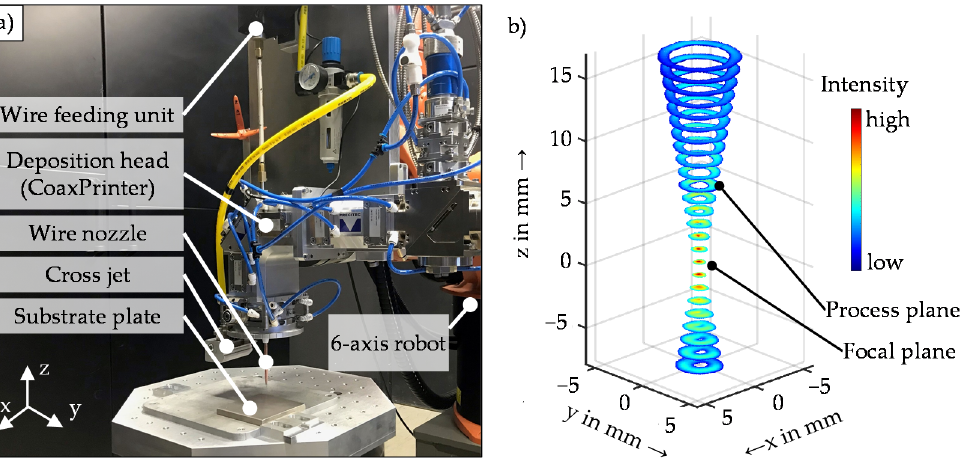
Figure 1. Experimental set-up: ( a ) main system components and ( b ) caustic of the hollow laser beam near the process.